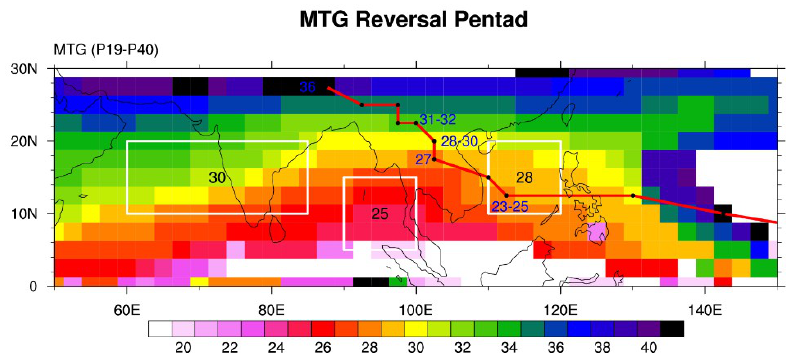
Figure 3. The pentad evolution of ( a , d ) the grid number in the region enclosed by the Z cent ‐10 gpm contour, ( b , e ) the latitude and ( c , f ) longitude of SAH gravity center, ( g ) the maximum intensity, ( h ) the latitude and ( i ) longitude of maximum SAH center from ( a – c ) pentad 1–72 and ( d – i ) pentads 13–43.